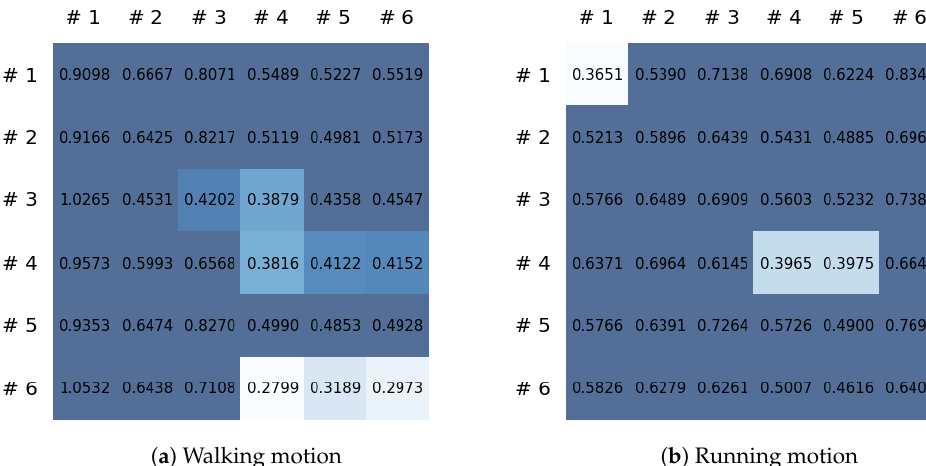
Figure 19. MSE values of the CNN model using CRP for each